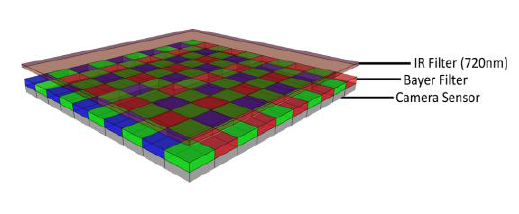
Figure 1. Bayer filter (Nikon, 2016)